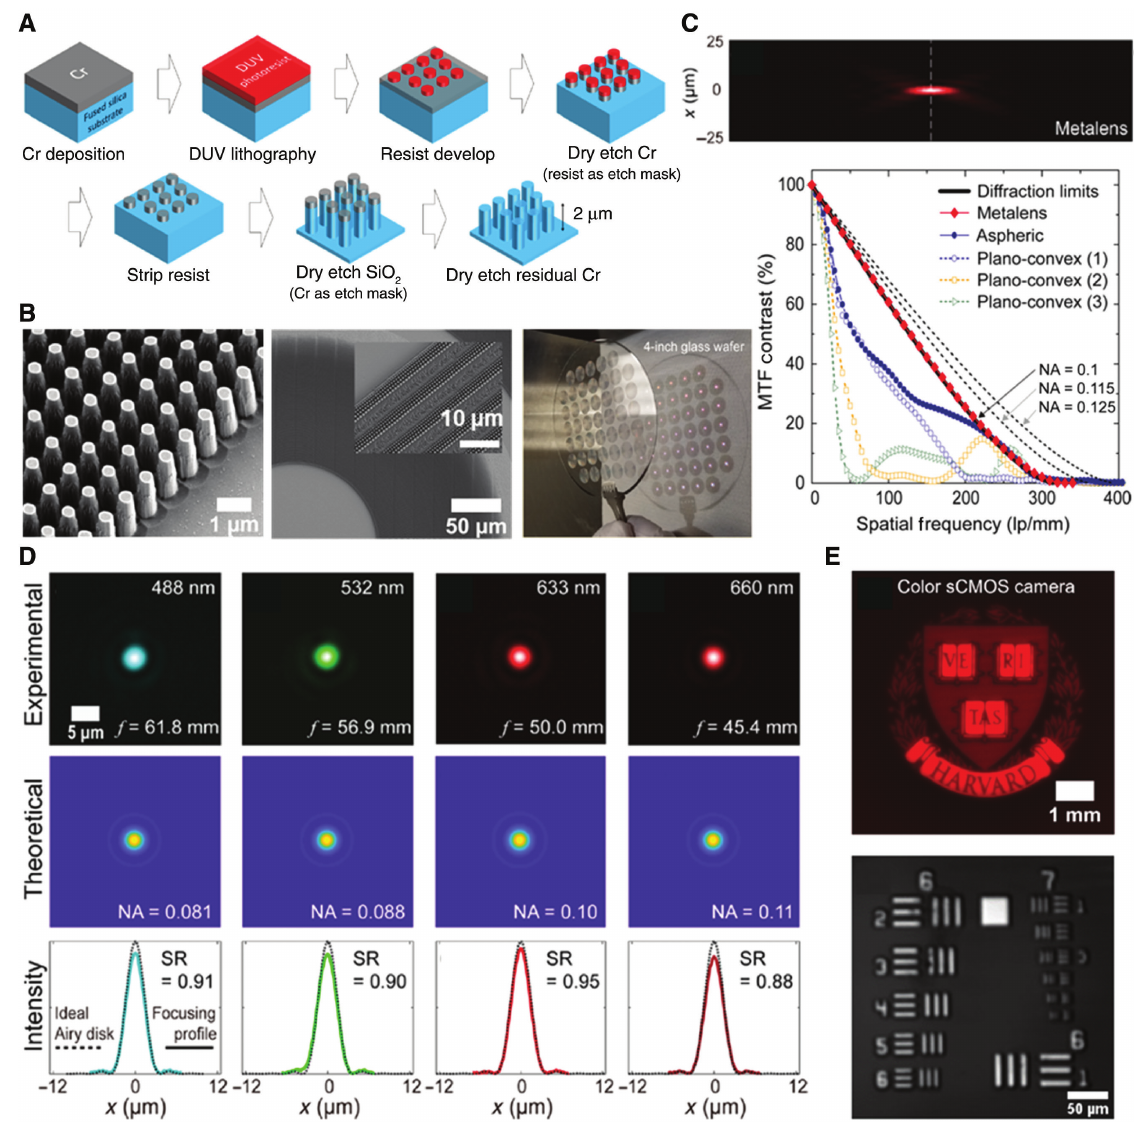
Figure 3: Metasurface-based devices working in visible patterned using a stepper with 248 nm light source. (A) Fabrication process flow of the metalens through direct etching on glass wafer. A Cr layer is first patterned using photoresist as etch mask. The patterned Cr layer is then used as etch mask for the glass nanopillars through dry etch. (B) Tilted-view SEM image of nanopillars with 2 μ m height (left), top-view SEM image of the metalens near the central area, with inset showing the nanopillars at the edge of the metalens (middle), and fabricated 4-inch glass wafer containing 45 metalens showing the focusing of the incident light in the visible wavelength range (right). (C) Intensity distribution along the z -direction measured at 633 nm wavelength (top) and comparison among the measured and idea MTFs for the lenses (bottom). (D) Measured intensity distribution at the focal plane under different wavelength in the visible wavelength regime (top row), theoretical intensity distribution at the focal plane (middle row), and measured intensity profile (solid line) in comparison to ideal intensity profile (dotted line) at the focal plane, showing SR values of 0.91, 0.90, 0.95, and 0.88, respectively (bottom row). (E) Colored Harvard logo obtained near the focal plane of the metalens by an sCMOS camera (top) and image of USAF resolution chart obtained using the metalens within a reflective scanning microscopy system (bottom). (A–E) Adapted with permission from [75]. © 2019 American Chemical